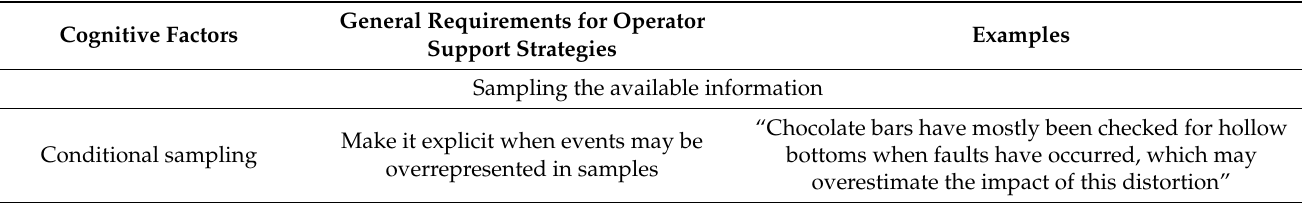
Table 1. Examples of deriving requirements for support strategies from the cognitive factors presented in Section 2. Cognitive